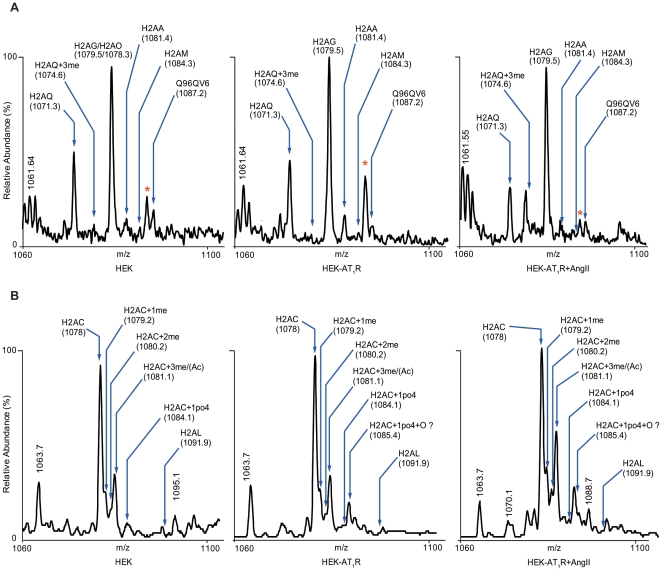
Mass spectrum of intact histone H2A from FPLC peaks showing resolution of isoforms and PTM.(A) The figure shows the spectrum expanded at 13+ charged state for all three (HEK, HEK-AT1R and HEK-AT1R+AngII) experimental conditions. The masses of the intact histone components were determined after deconvolution of the multiple charge ion series (not shown). This peak fraction contains multiple isoforms of H2A. This spectrum shows that H2A isoforms H2AG/H2AO (1079.5 m/z) did not appear in HEK-AT1R+AngII treated condition; the appearance of H2AM can also be seen in this peak (See Table 2). (B) Molecular masses of FPLC peak 2: intact histones from H2A peak determined after deconvolution of the multiply charged ion series, expanded at 13+ charged state for all three experimental conditions. In this peak fraction the major isoform is H2AC (1078 m/z) and its modifications. In this spectrum, phosphorylation of H2AC is reduced (H2AC+1P) (1084.1 m/z) in HEK-AT1R and HEK-AT1R+AngII conditions and an increase of H2AC monomethylation can be seen (See Table 2).